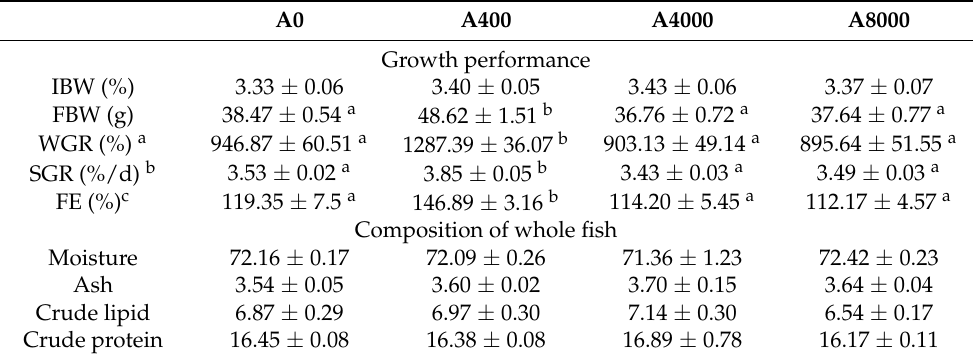
Table 3. Effects of dietary AMP on growth performance.